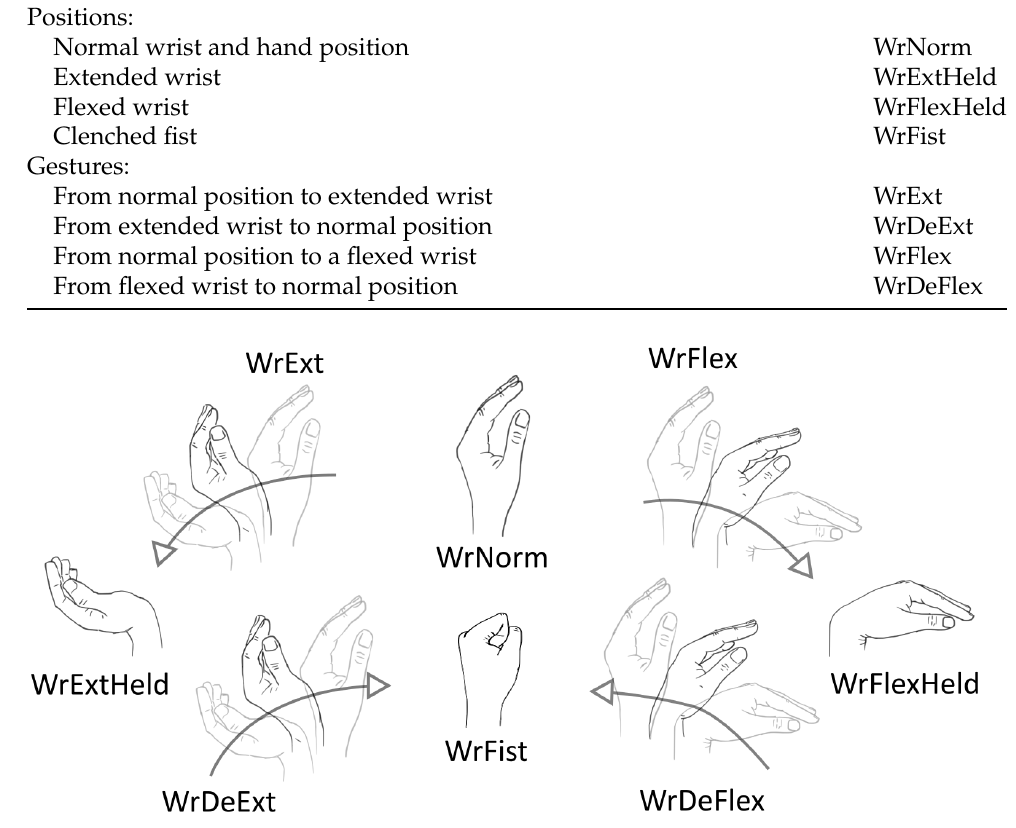
Figure 4. Illustration of the hand motions (positions and gestures) used in the classification tasks and their respective